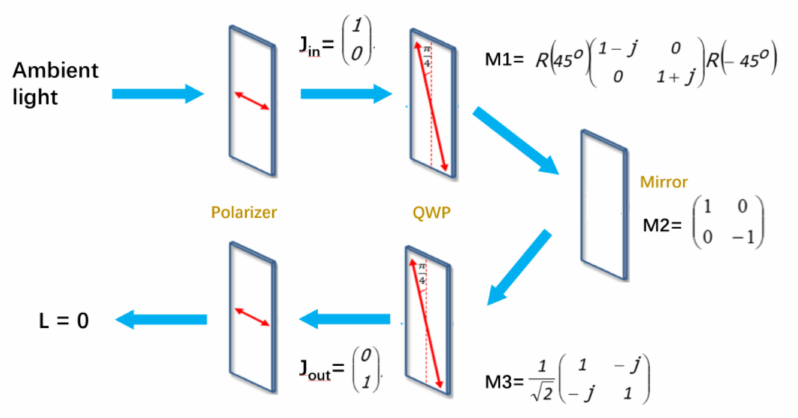
Figure 4. The optical system to eliminate ambient light reflection, including the jones matrix calcula- tion to show the principle.